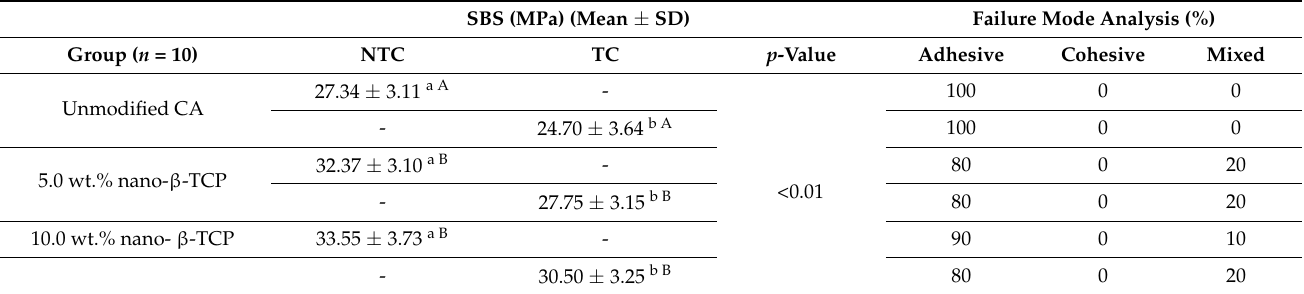
Table 1. Means and standard deviations for bond strength and failure modes among the study